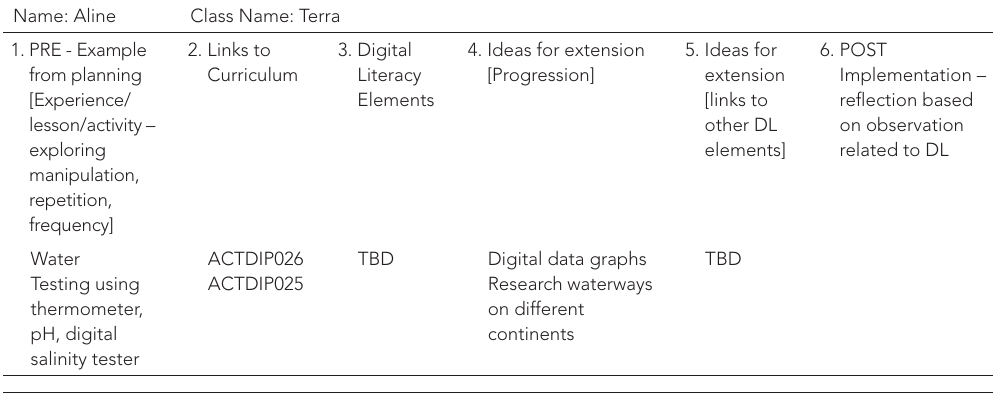
Table 1: Planning and reflection template, digital literacies and digital technology – partially